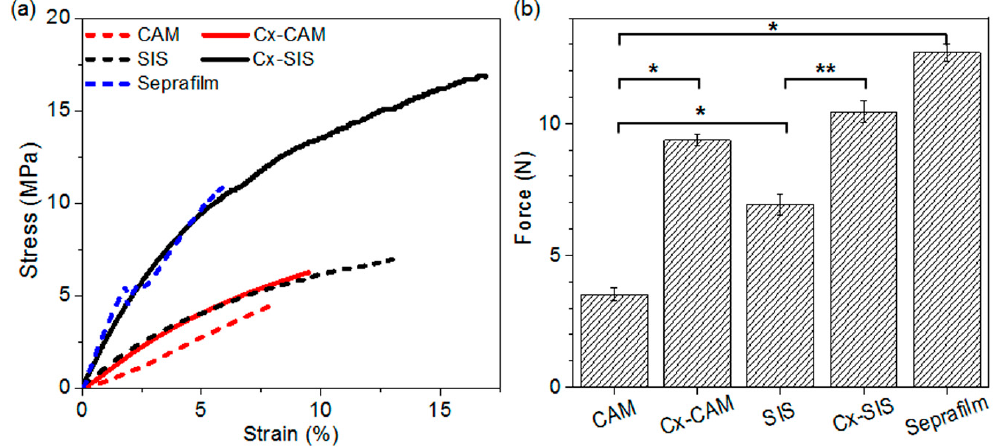
Figure 3. ( a ) Stress–strain curves and ( b ) tensile strengths of CAM, Cx-CAM, SIS, Cx-SIS films, and Seprafilm. (* p < 0.001, ** p < 0.05).